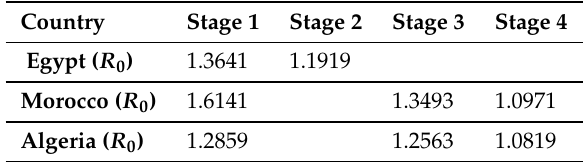
Table 1. The basic reproduction number in each country during the different stages of the